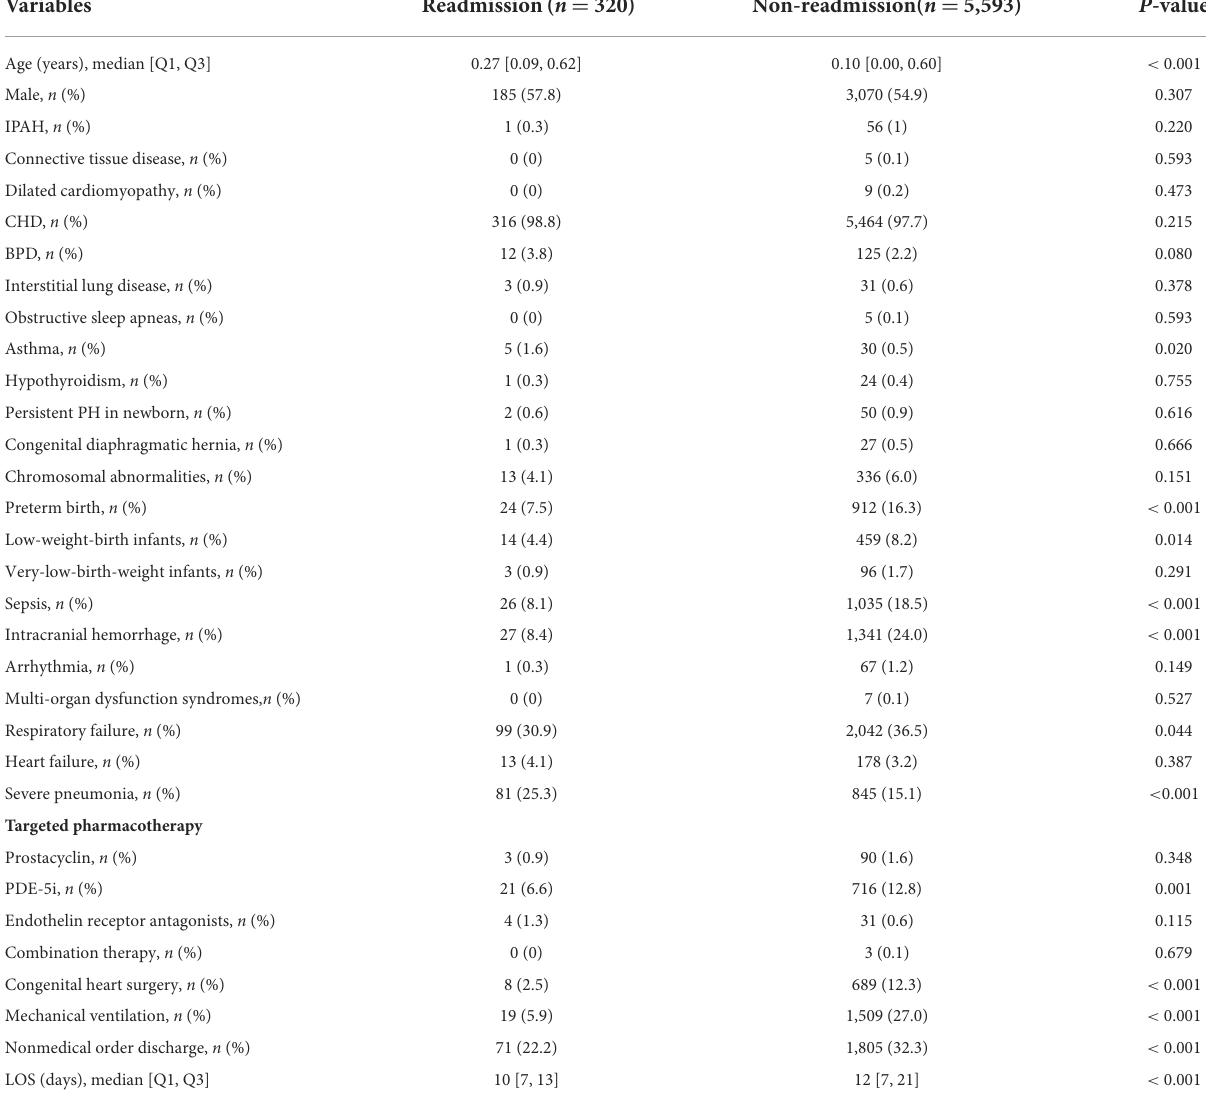
TABLE 1 Baseline characteristics of pediatrics with pulmonary hypertension